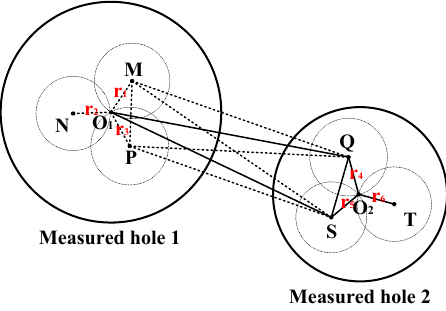
Figure 6. The measurement model of the hole–center distance.